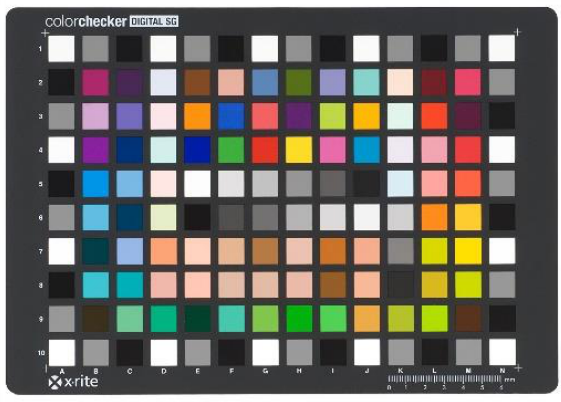
Figure 2. X-rite ColorChecker SG Digital Colour